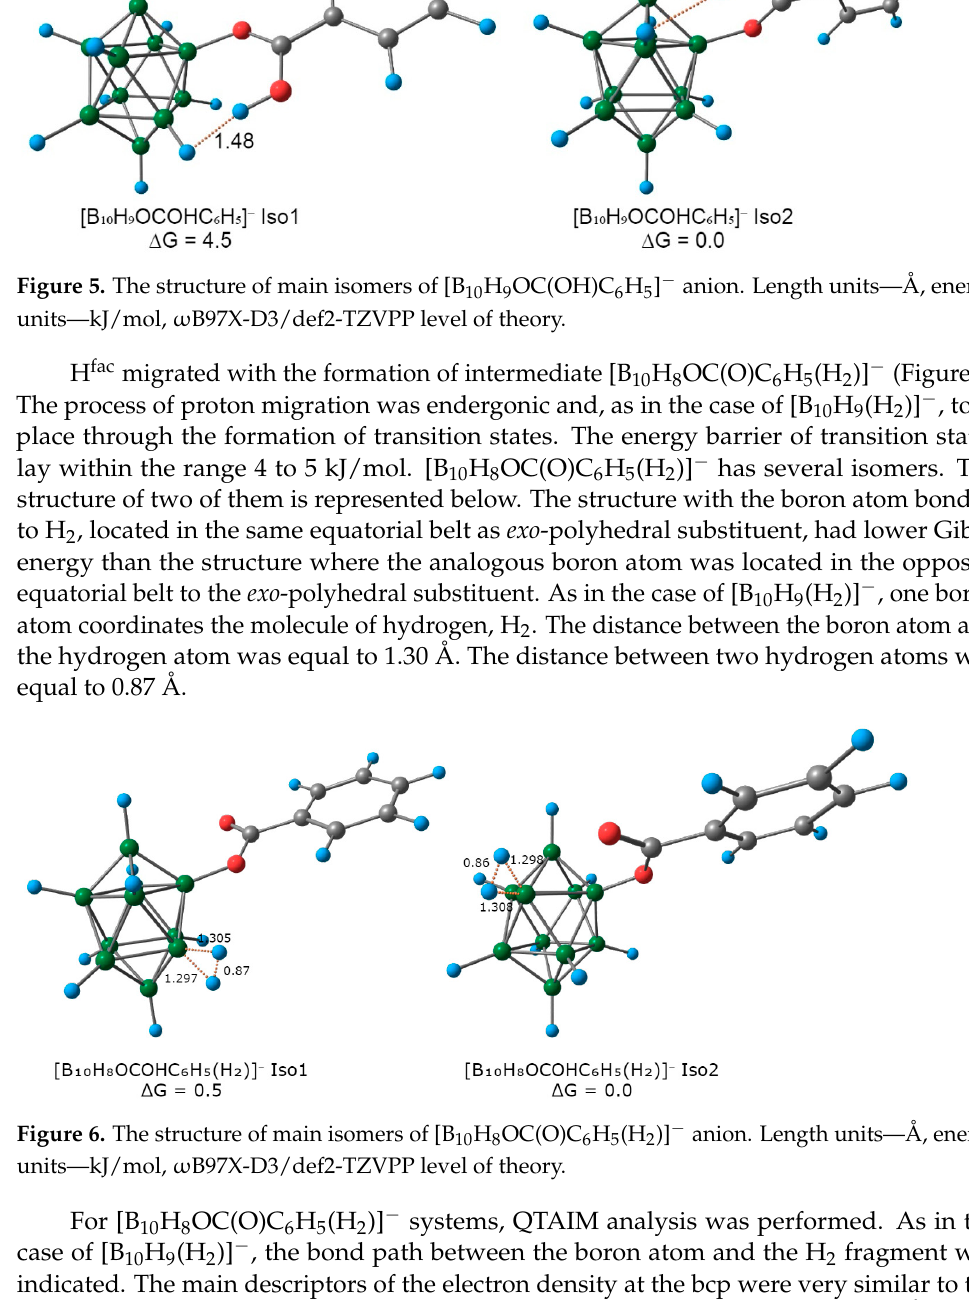
Figure 5. The structure of main isomers of [B 10 H 9 OC(OH)C 6 H 5 ] − anion. Length units—Å, energy units—kJ/mol, ω B97X-D3/def2-TZVPP level of theory.